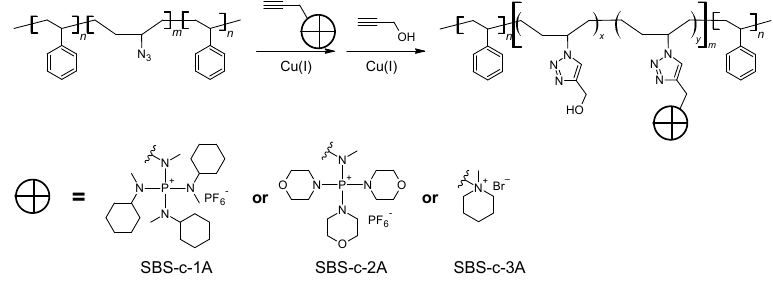
Scheme 6. Polyelectrolytes synthesized via click